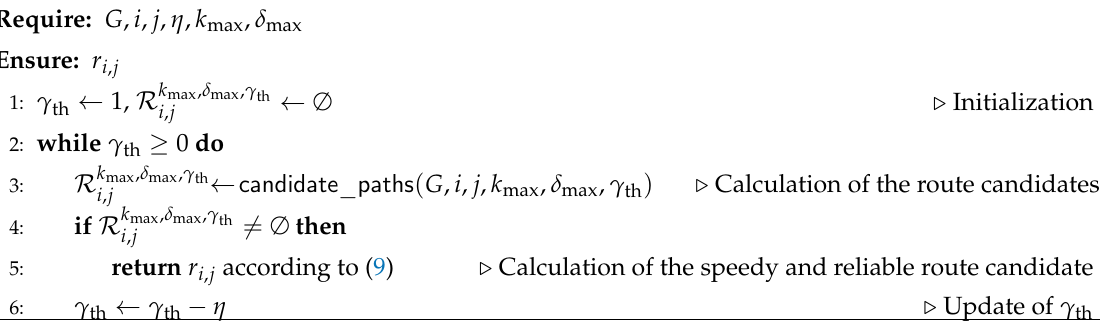
Algorithm 2 speedy_reliable_path ( G , i , j , η , k max , δ max ) : Calculation of speedy and reliable route candidate r i , j between evacuee i and refuge j